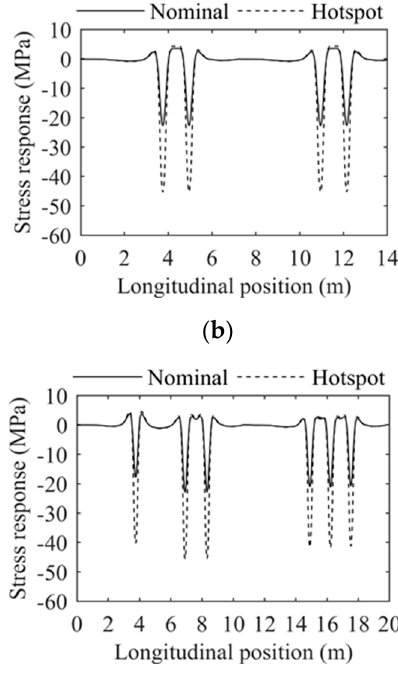
Figure 13. Derivation of stress spectra using Monte Carlo simulations. The Latin hypercube sampling (LHS) method [42] has been incorporated in the MC simulations to ensure better coverage over the whole distribution, which could in turns notably improve the sampling efficiency. As mentioned, a considerable number of samples is required in the MC simulations to simulate the stochastic traffic comprehensively. Thus, a large-size database is first generated based on the stochastic traffic model, i.e., 10 7 samples in this study. At the same time, the influence surface could be generated for the different RD joints. Then, the traffic database could be transformed into the database of stress history using the method illustrated in Figure 10. Finally, stress spectra could be established using the rain-flow method [29]. 5.4. Fatigue Life Assessment In the Eurocode 3 (EC3) [23], the three-stages stress-life (S-N) model is proposed, including two particular points, i.e., the transition point at five million cycles and the cut-out limit at 10 million cycles. Between the transition point and the cut-out limit, the power index m will change from three to five. Beyond the cut-out limit, infinite fatigue life could be expected for welding joints, indicating that the power index m is infinite. However, this only happens in the ideal situation when the pure constant amplitude loads are applied [29]. According to the fracture mechanics [44],